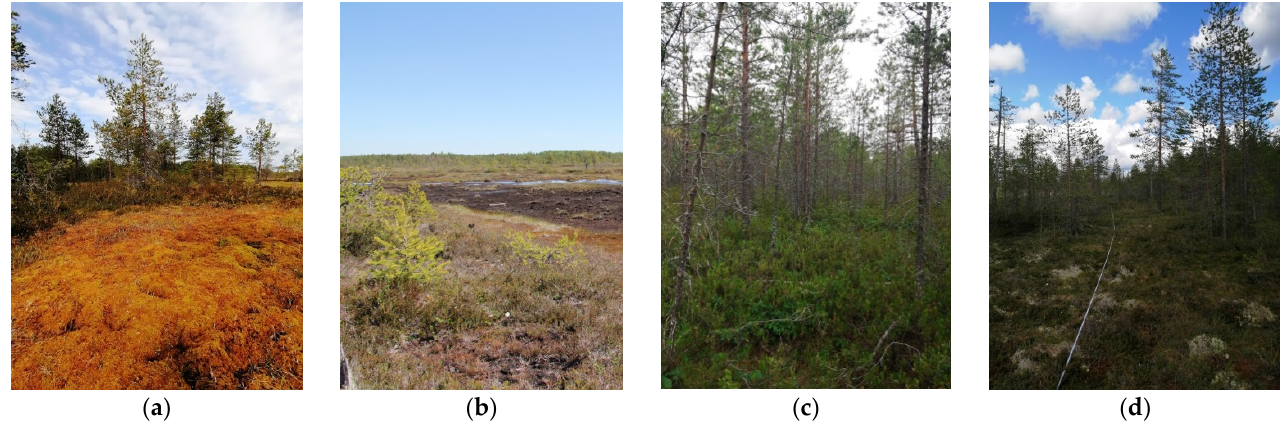
Figure 3. The vegetation cover of test sites: undrained test sites ( a ) UD-1; ( b ) UD-2; ( c ) effectively drained test site D-2; ( d ) rewetted test site RW-2. Table 1. Properties of the forest stand of test sites.